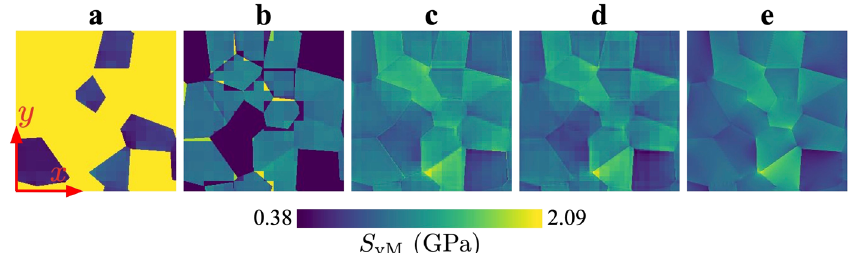
Fig. 5 Effect of kernel size on predicted stress distribution. The predicted von Mises equivalent stress distribution for kernels with size k × k , k = 3, 5, 7, 9, shown in ( a ), ( b ), ( c ), and ( d ), respectively, compared to the results obtained from the full- fi eld DAMASK simulations used here as reference ( e ). All models were trained under the same conditions.